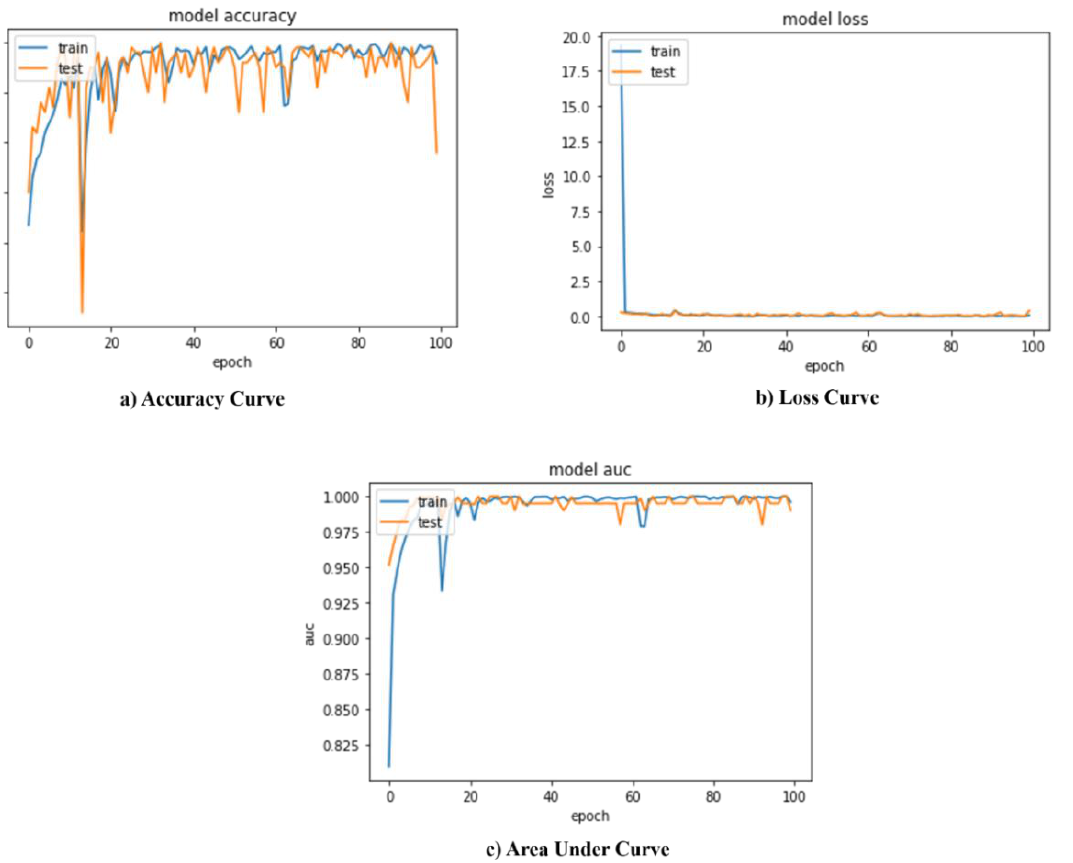
Figure 6. Performance evaluation metrics of proposed model COVID-19/pneumothorax classifica- tion a ) Accuracy Curve, b ) Loss Curve and c ) Area Under Curve.